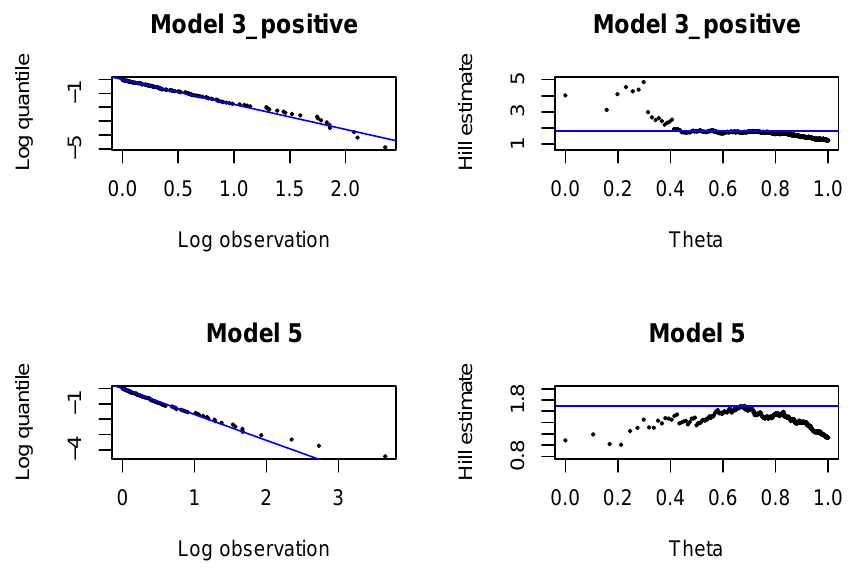
Figure A13. Pareto quantile plots and altHill plots for incremental payments and changes in claim incurred in k =